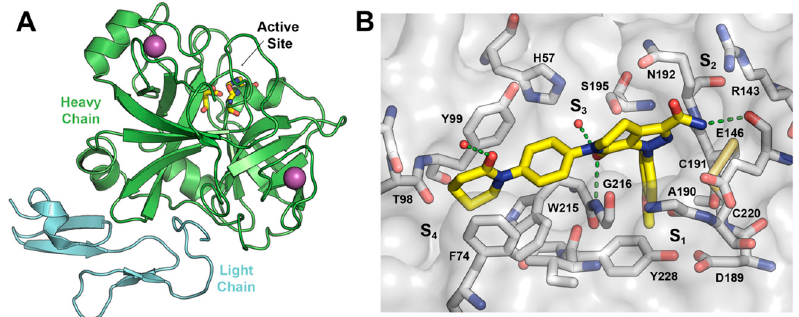
Figure 2. ( A ) Schematic representation of FXa protein structural domains showing the location of the binding site and ions within the heavy chain (green cartoon) and the light chain (light blue cartoon); ( B ) The X-ray crystal structure of Apixaban (yellow carbons) in complex with human FXa (PDBid 2P16). Essential amino acids and binding pockets are indicated; hydrogen bonds between Apixaban and FXa residues and structural waters are shown as green dotted lines.